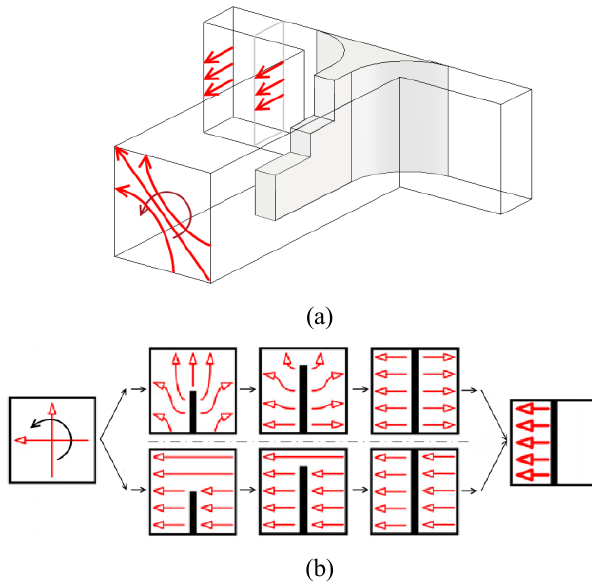
FIGURE 3. Propagation of LHCP mode in a septulum polarization converter: (a) propagation from port to port; (b) representation of the transmission as a superposition of orthogonal modes.